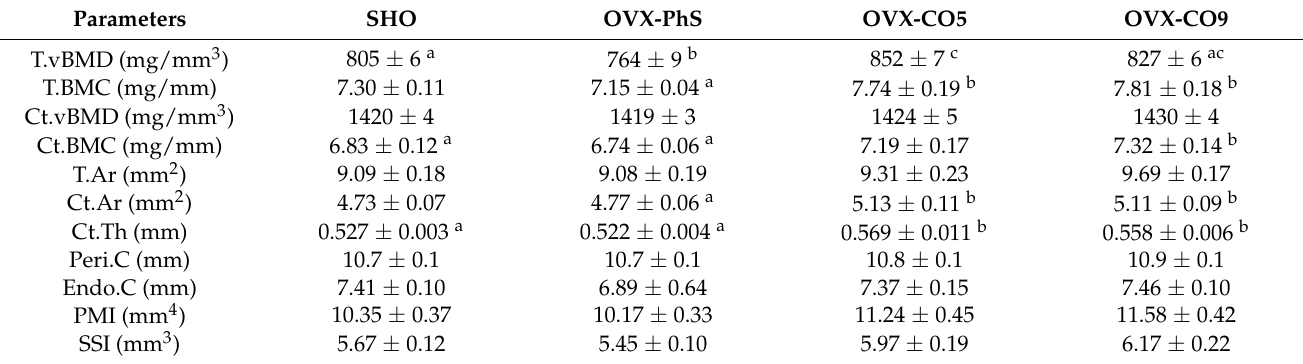
Table 3. Tomographic analysis (pQCT) of bone tissue in the middle part of femur diaphysis.